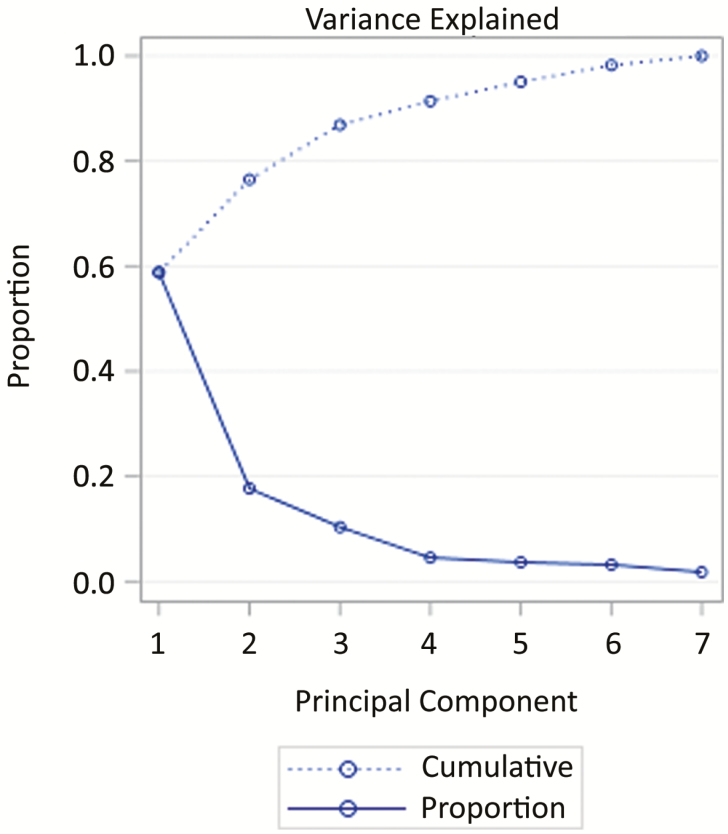
An example plot of the proportion of variance explained by each additional component in principal component analysis. Variance explained by each additional component can vary considerably based on the data you are working with (Shah et al., 2018).